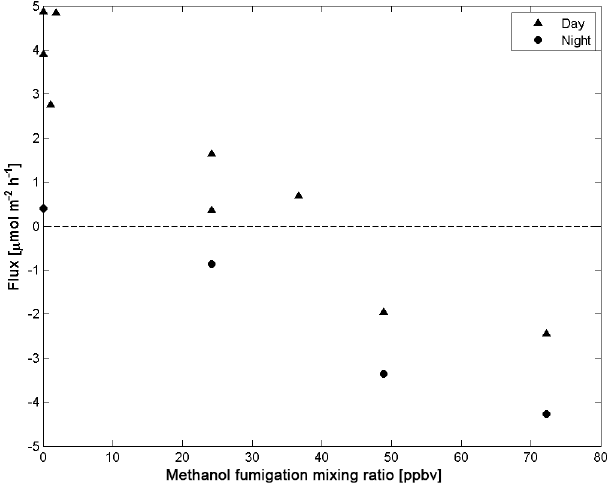
Figure 7. Example of enclosure flux measured as a function of fu- migation mixing ratio for methanol in the